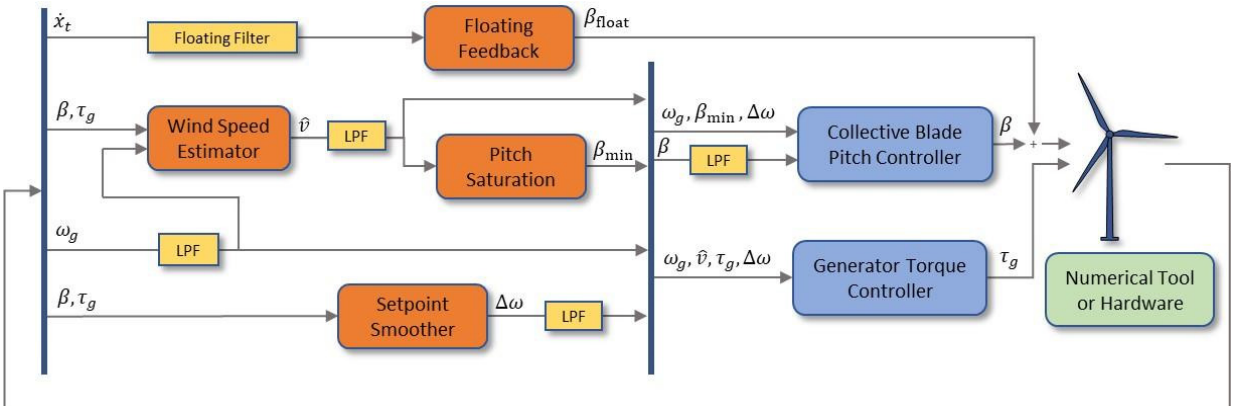
Figure 2. ROSCO diagram.